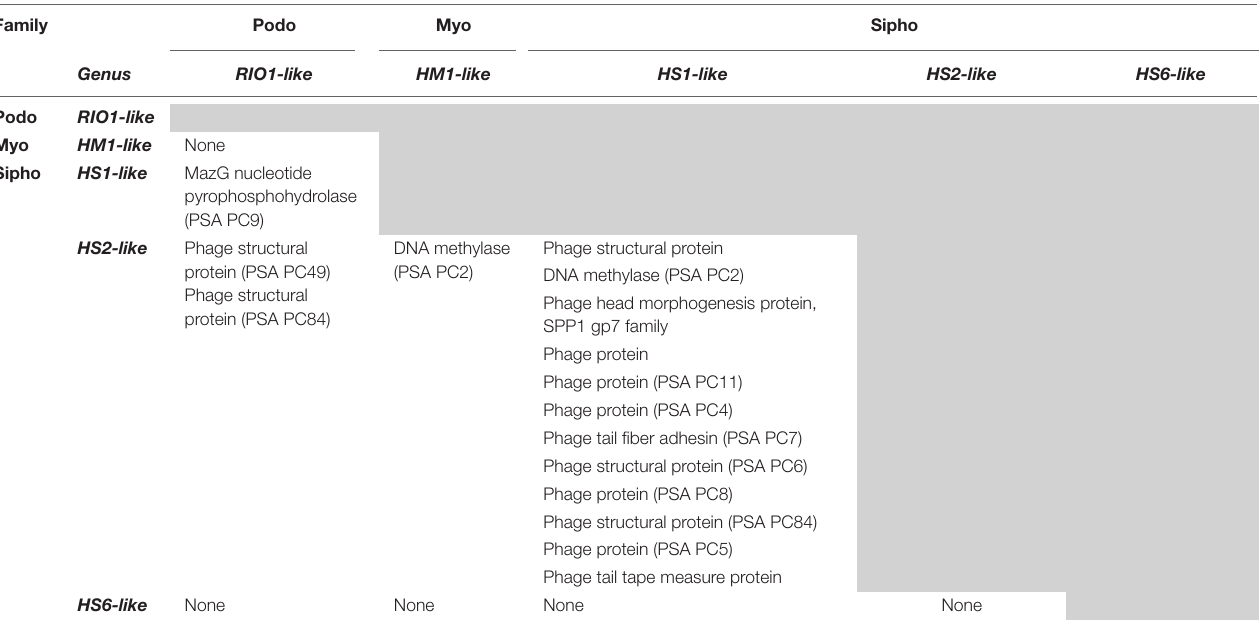
TABLE 2 | Overview of proteins shared within and between